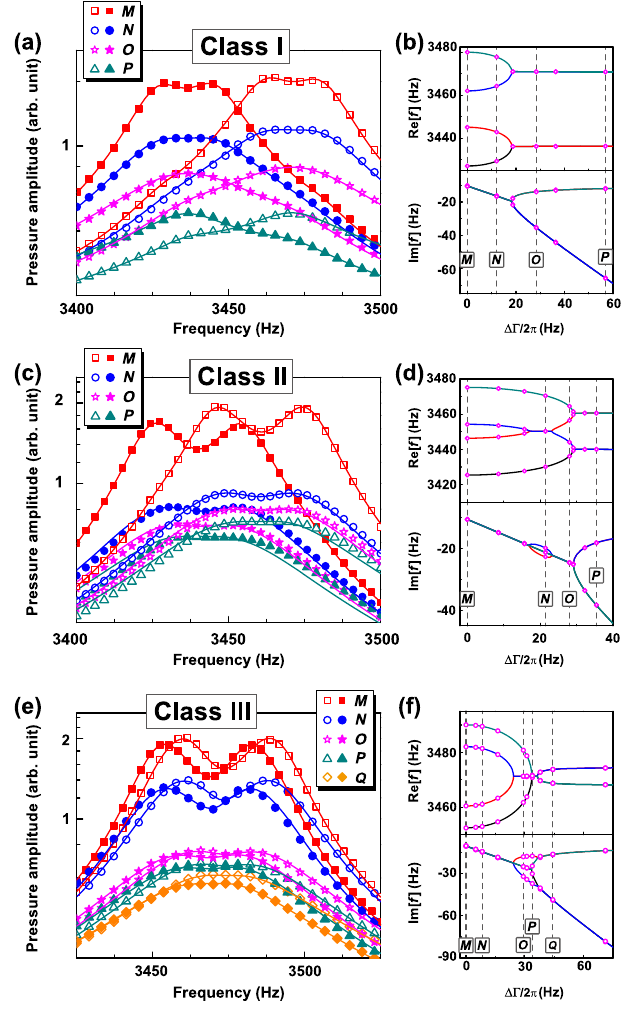
FIG. 4. Measured pressure response spectra at cavity B (filled symbols) and D (open symbols) for some certain point in class I (a), class II (c), and class III (e) separately. The coupled cavities are pumped incoherently. Results labeled M to P or Q show increasing amounts of asymmetric loss. The corresponding solid curves are fitted using a Green function method [Eq. (3)]. Real and imaginary parts of eigenfrequencies as functions of asym- metric loss ΔΓ for experimental results in (a), (c), and (e) are plotted in (b), (d), and (f) accordingly, in which open symbols are obtained by using parameters fitted from experimental results and solid lines are from analytical models by using fitted parameters without sponge and putty. The colors (black, red, blue, dark cyan) represent different eigenfrequencies of our